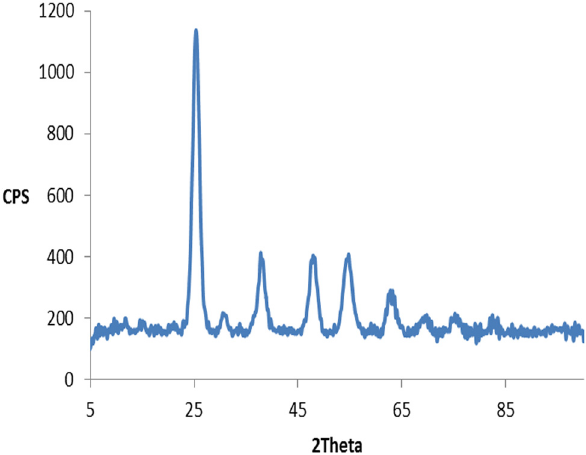
Figure 1: XRD pattern of lupin TiO 2